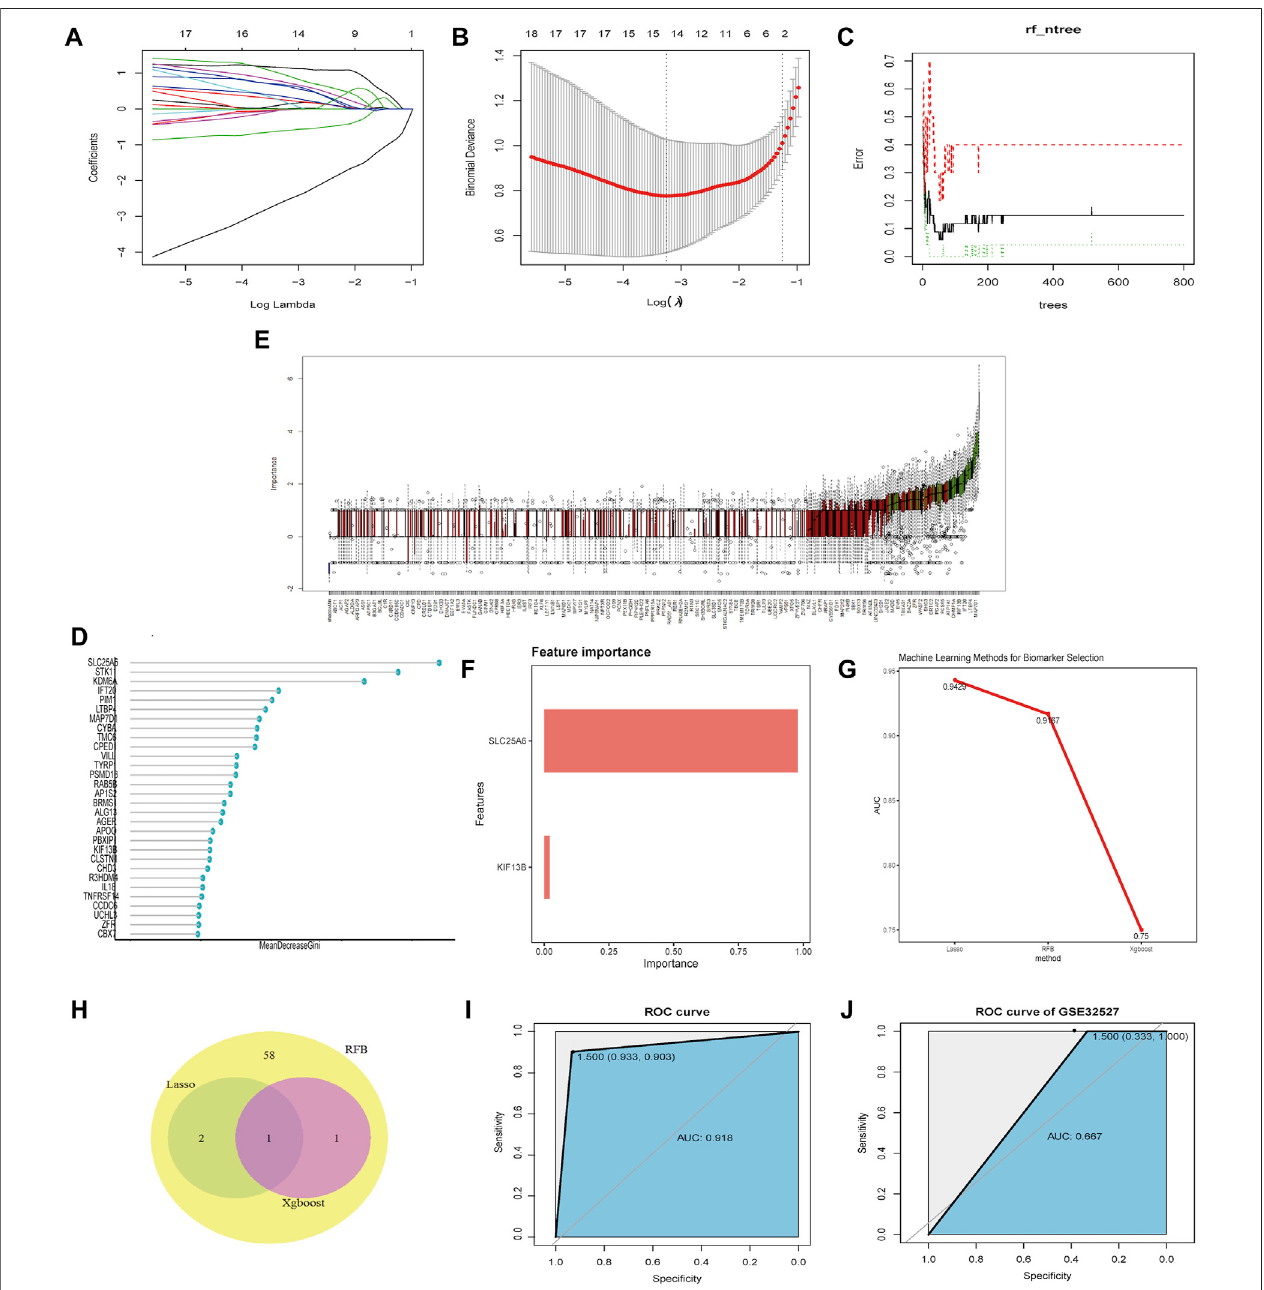
FIGURE 5| Screening and validation ofbiomarkers. (A – B) : LASSO was employed to screen biomarkers. The different colors correspond to distinct genes. (C – E) : The RFB algorithm was used to screen potential biomarkers. (E) : ROC of the hub genes useful for the diagnosis of otologic disorders in TS. (F) : The XGBoost algorithm was used to screen potential biomarkers. (G) : The feature selection performance of the three machine-learning algorithms (LASSO, RFB, and XGBoost) was evaluated with training and test sets. A ROC analysis was performed to calculate the AUC. (H) : Venn diagrams showing the intersection of biomarkers obtained from three machine-learning algorithms. (I) : ROC curve of SLC25A6 in the merged dataset. (J) : ROC curve of SLC25A6 in the validation dataset (GSE32527).